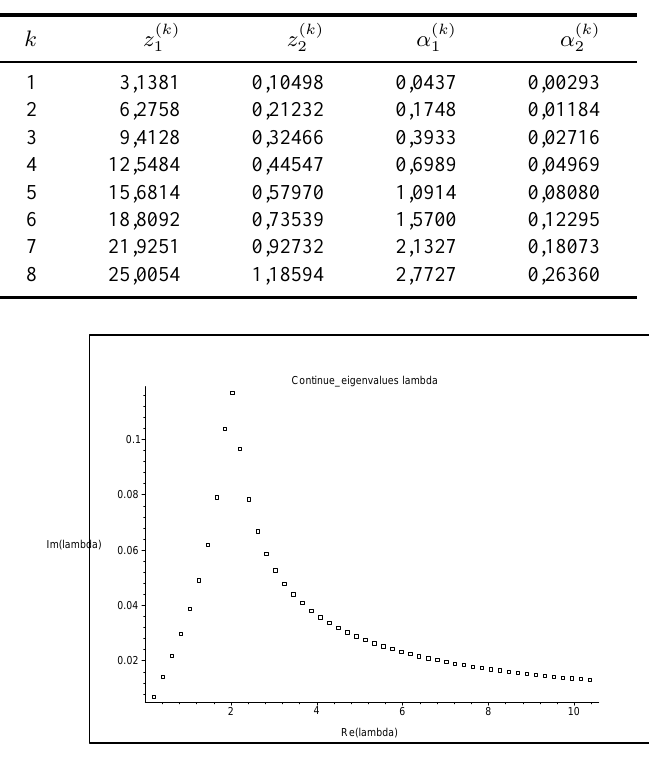
Figure 1. Eigenvalues of the continuous problem (cid:21) k , k = 1 ; 59 : monotonically decrease in time,